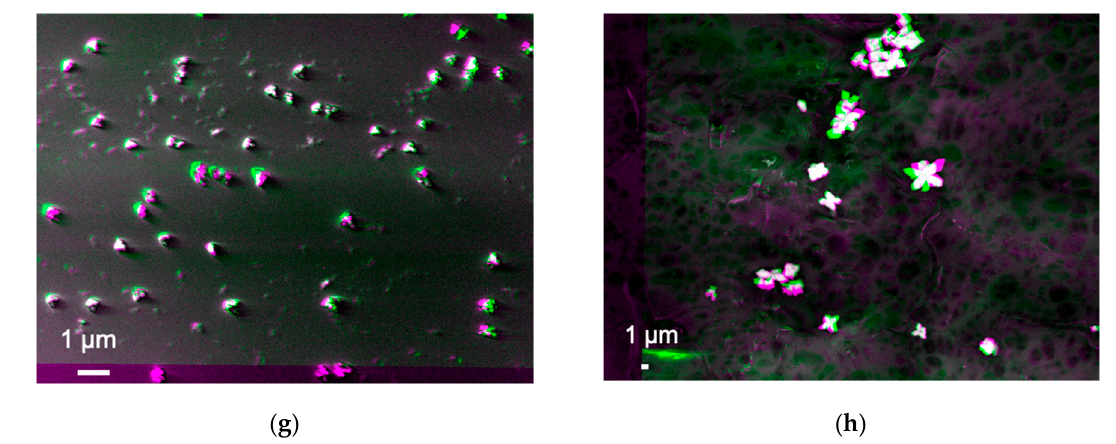
Figure 2. Processed images of the nanoparticle–substrate interfaces after subtracting two images taken at the acceleration voltages of 18 and 20 keV on the samples grown on ( a ) Si/SiO 2 , ( b ) n -Si(001), ( c ) p -Si, ( d ) n -Si(111), ( e ) Ni, ( f ) Al, ( g ) 128° Y-cut LiNbO 3 and ( h ) PTFE substrates